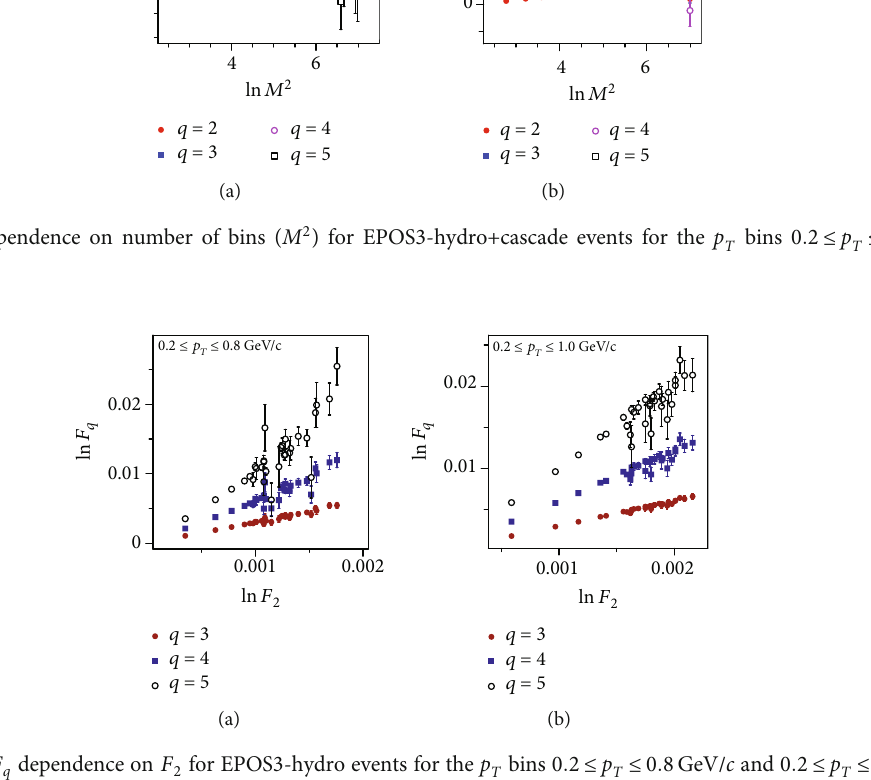
q dependence on